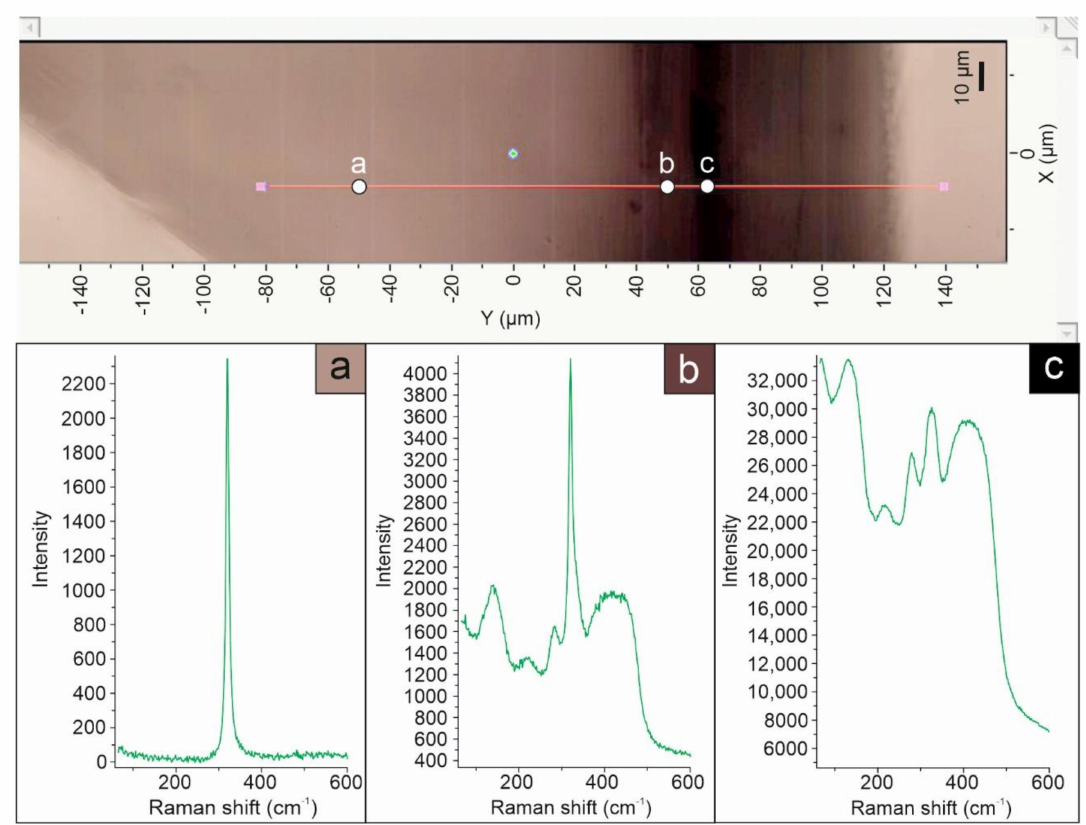
Figure 7. Results of a Raman line scan. ( a ) In the colorless or pale purple zones, only a sharp fluorite band appears in the spectrum; ( b ) in the medium purple zone, the fluorite band and the structural damage are also visible; ( c ) the intensive Raman feature from dark purple zones obscures the fluorite